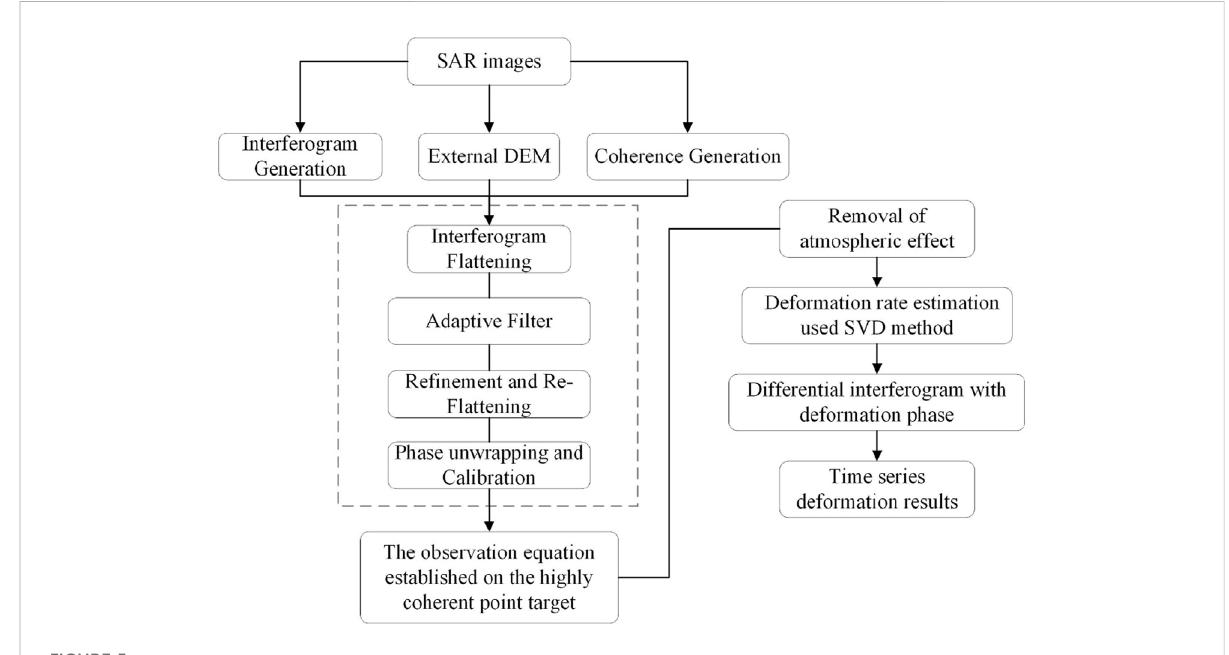
FIGURE 5 Processing fl ow of SBAS-InSAR